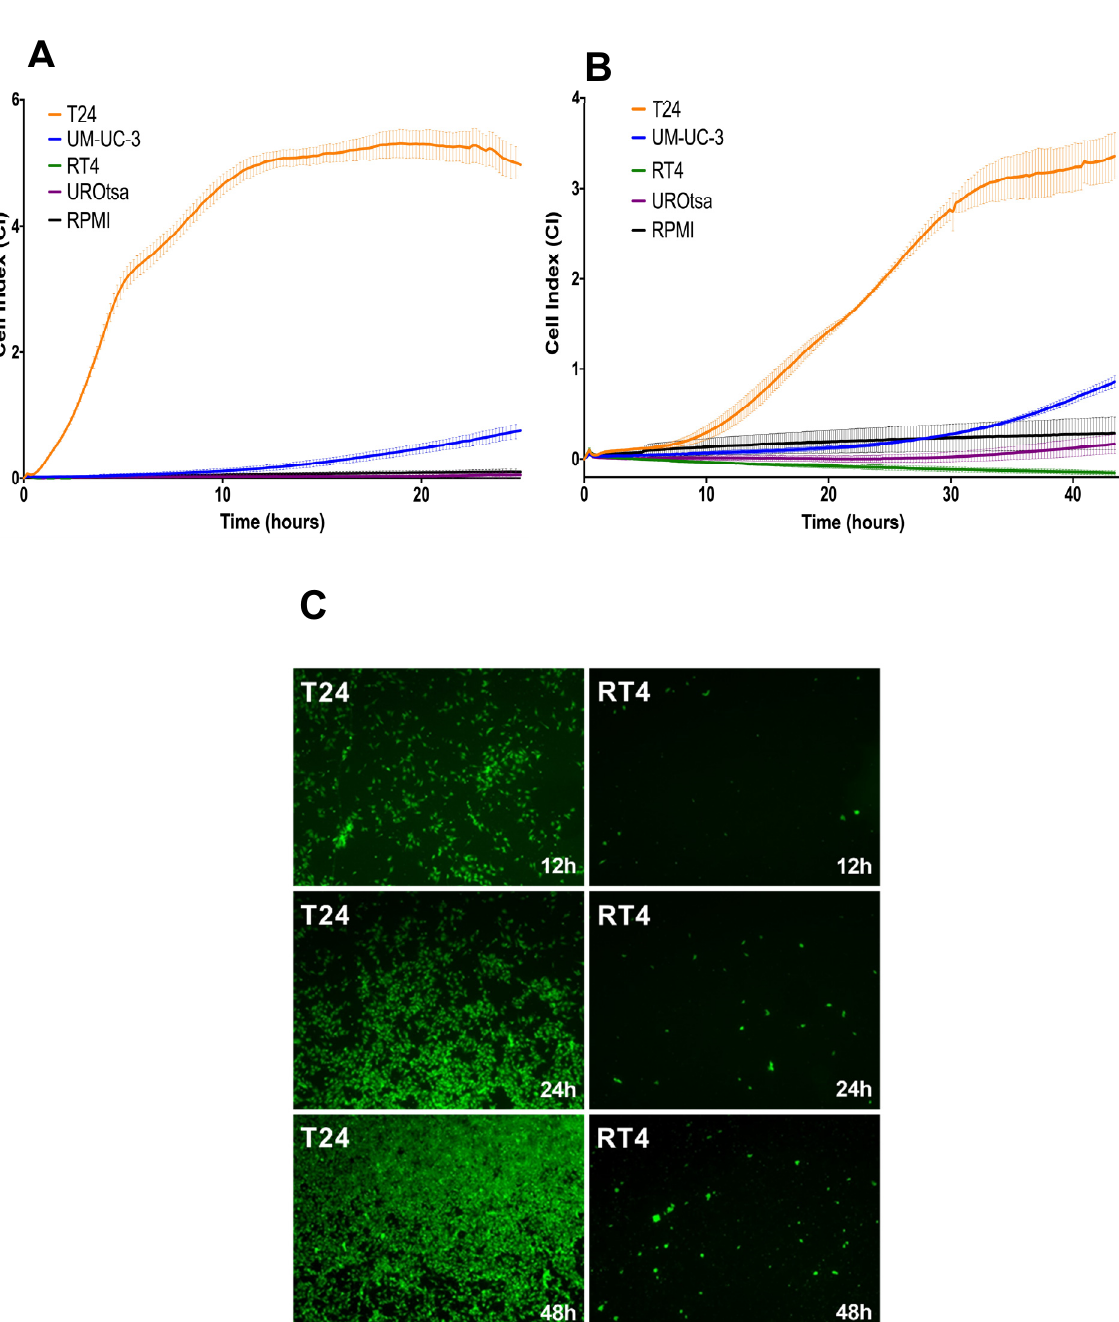
Figure 2. Evaluation of migration and invasion capacity of bladder cancer cell lines by RTCA and Boyden chamber assays. Migration ( A ) and invasion ( B ) capacities of bladder cancer cell lines as determined by RTCA impedance sensing. The cell index (CI) directly correlates to the migration and invasion capacity of cells (see Materials and Methods for experimental details). The experiment was performed three times, with quadruplicates of each experiment, and similar results were obtained. Depicted are the mean CI ± SD calculated from four replicates of each experiment ( n = 3). ( C ) Modified Boyden chamber assay. Tumor cells stained with CellTracker™ Green CMFDA Dye migrate through a HUVEC-coated membrane. After 12, 24, and 48 h, T24 cells were detected in the lower well (green signal) at a much higher rate than RT4 cells. Representative immunofluorescence images of at least three independent experiments are shown.